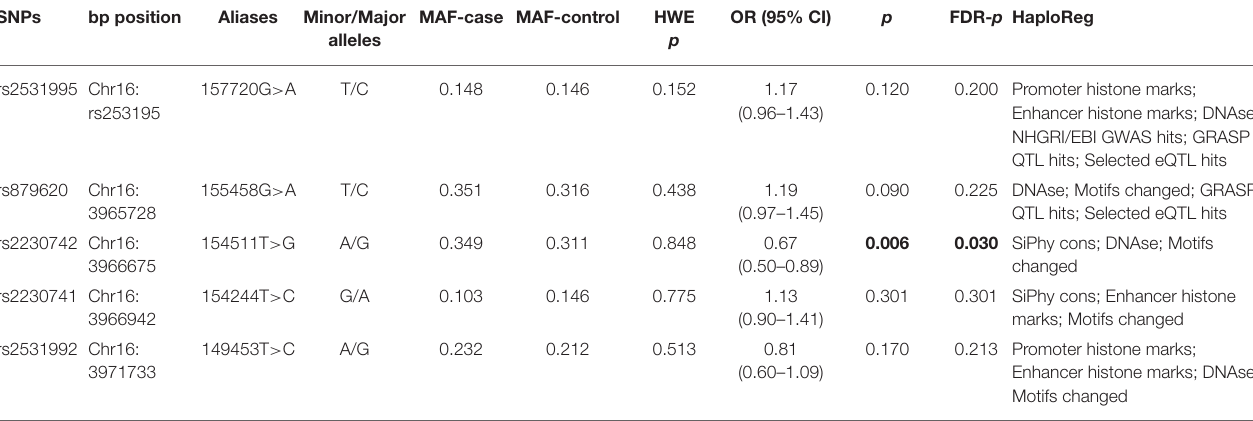
TABLE 2 | Summarized information of selected SNPs in the ADCY9 gene. SNPs bp position